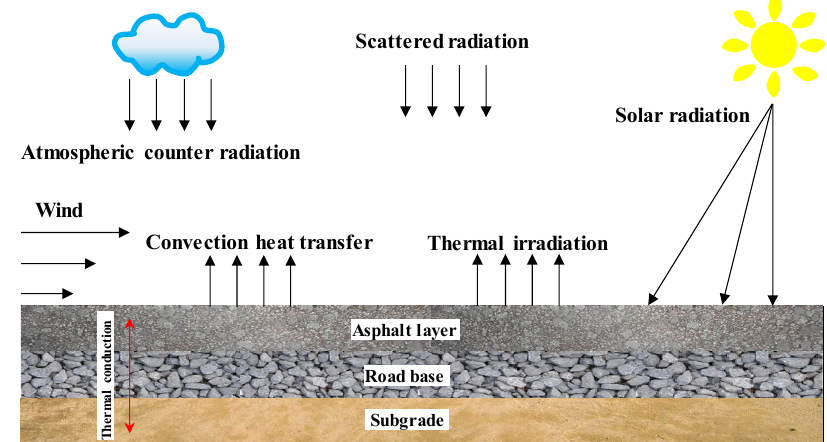
Figure 6. Environmental conditions of asphalt pavement structure.